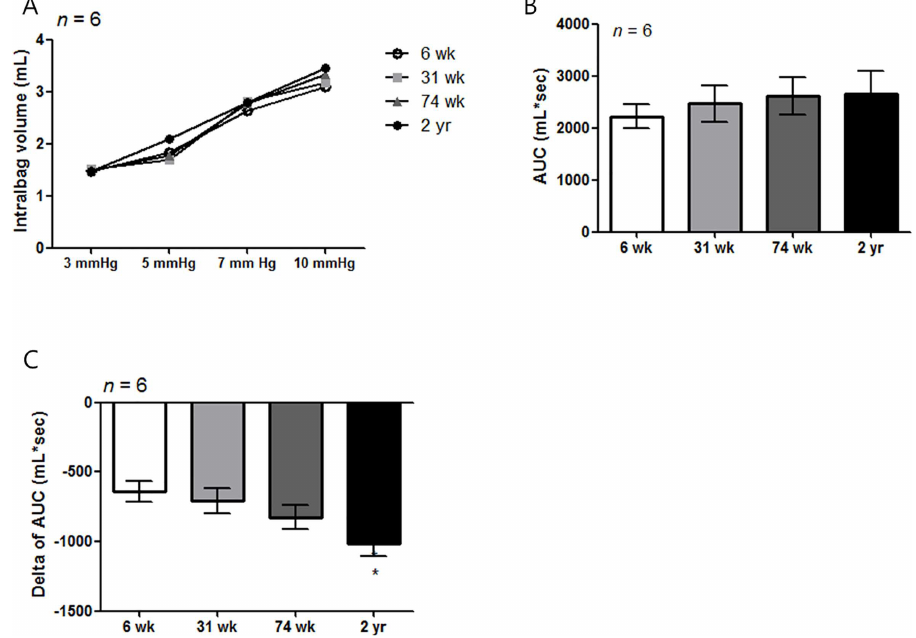
Fig 9. Measurement of gastric volume change and influences of L-NAME in different aged rat group. (A) The graph of pressuredependentvolume curve did not show statistical difference in each given pressure ( n = 6 per group). (B) Pressure dependent AUC (mL * sec)curve did not show any difference as aging ( n = 6 per group). After treatment with L-NAME (10 mg/kg), the delta of the AUC significantly decreased in the 2-yr- old rats compared with the 6-wk-oldage rats ( P < 0.05). * P < 0.05 compared with